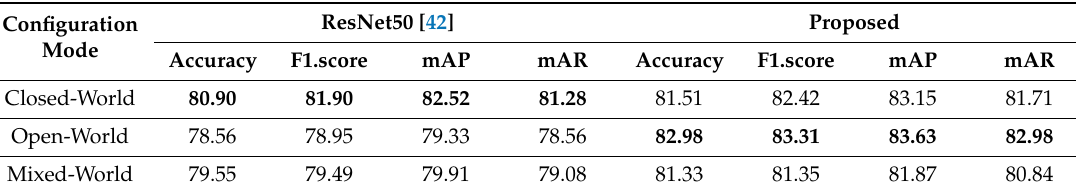
Table 10. Closed-world, open-world, and mixed-world performance comparisons of our modified model and ResNet50 [42] (unit: